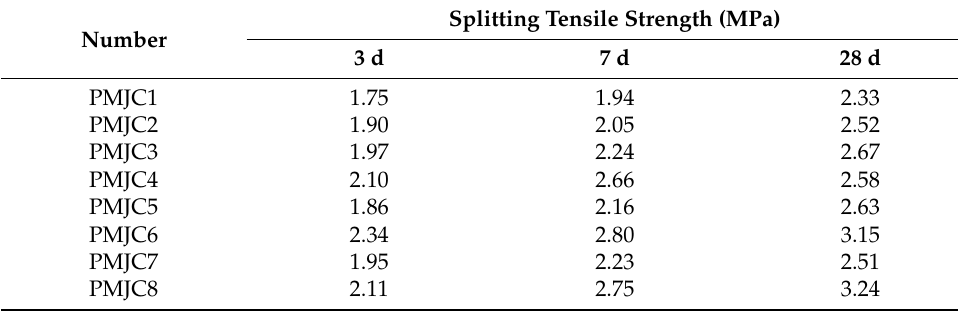
Table 8. Results of the cube splitting tensile strength test.